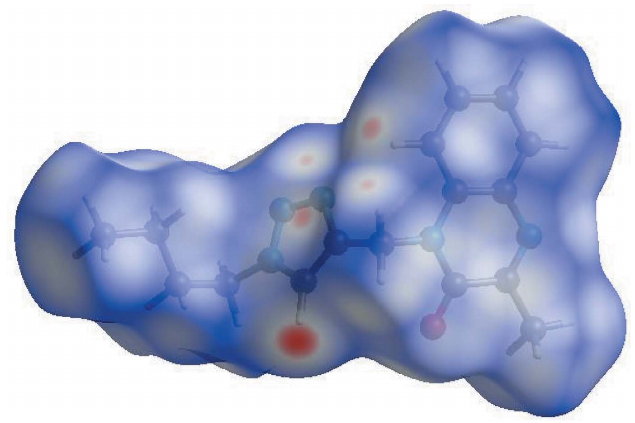
Figure 3 View of the three-dimensional Hirshfeld surface of the title compound plotted over d norm in the range (cid:4) 0.2380 to 1.1723 a.u.